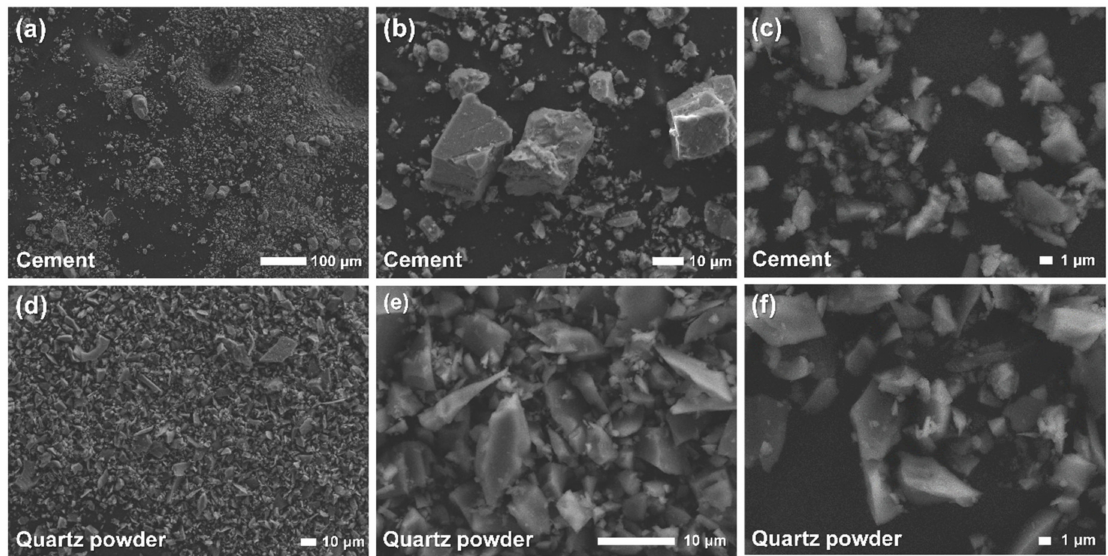
Figure 3. SEM images of cement ( a – c ) and quartz powder ( d – f ) with various resolutions.